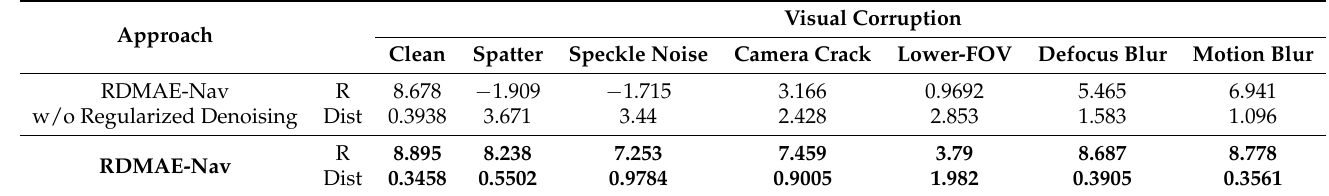
Table 6. Contributions of Regularized Denoising on the navigation behavior of RDMAE-Nav by comparing R and Dist